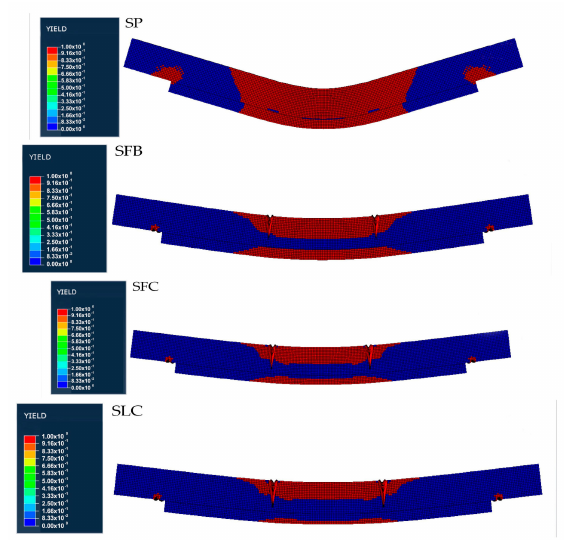
Figure 5. Numerical plasticization pattern for each